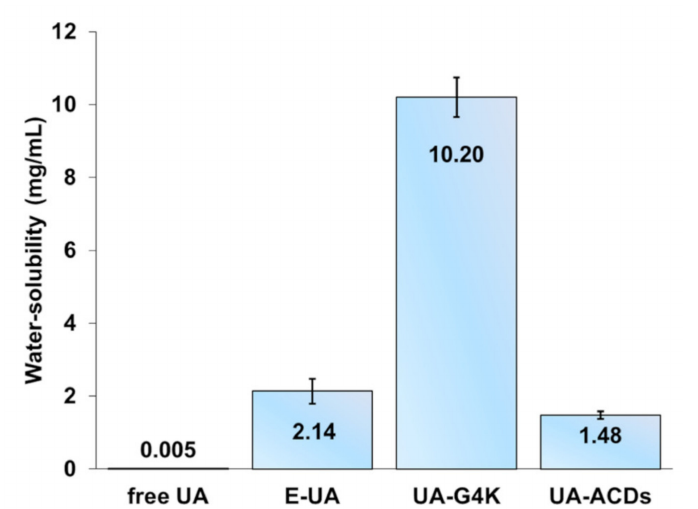
Figure 10. Water solubility of pristine UA (free UA), of nanotechnologically-manipulated UA released in water solution (HPLC) (E-UA), of UA-G4K, and of UA cyclodextrins inclusion complexes (UA- ACDs), herein reported as a mean of the literature data ±